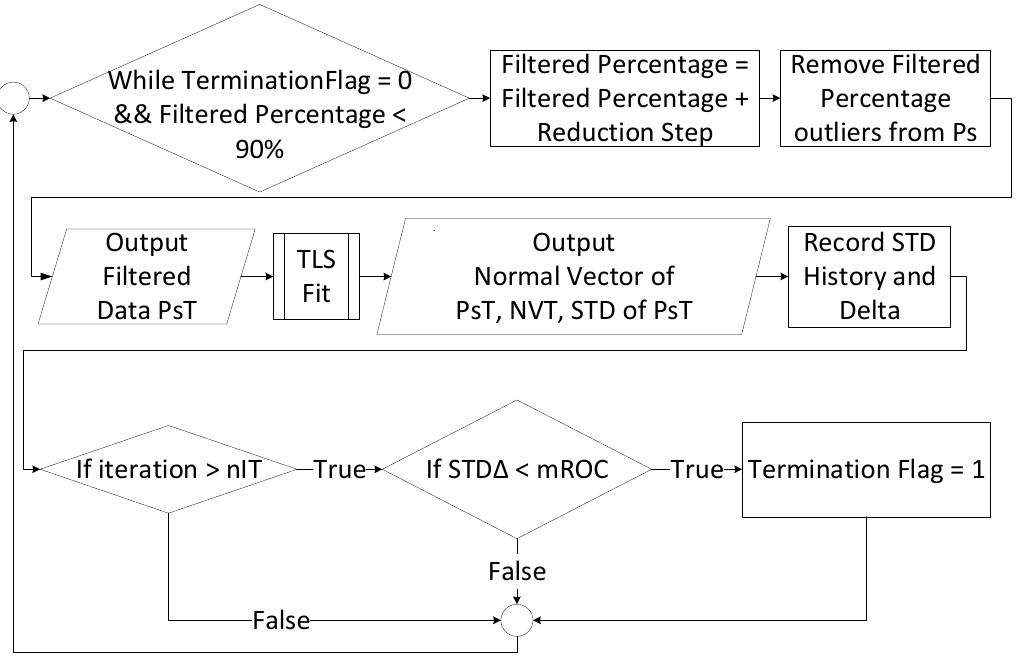
Figure 3. Main loop for the data reduction algorithm, with filtered output from step 1 (PsT).